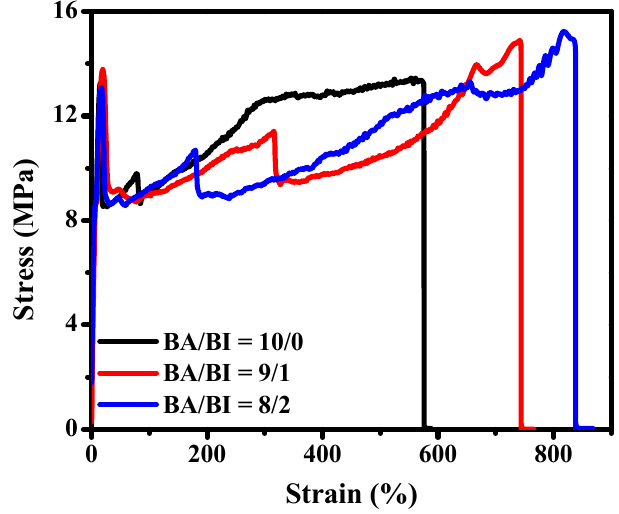
Figure 9. Stress-strain curves of PBABI copolyesters with a ratio from 10/0 to 8/2.